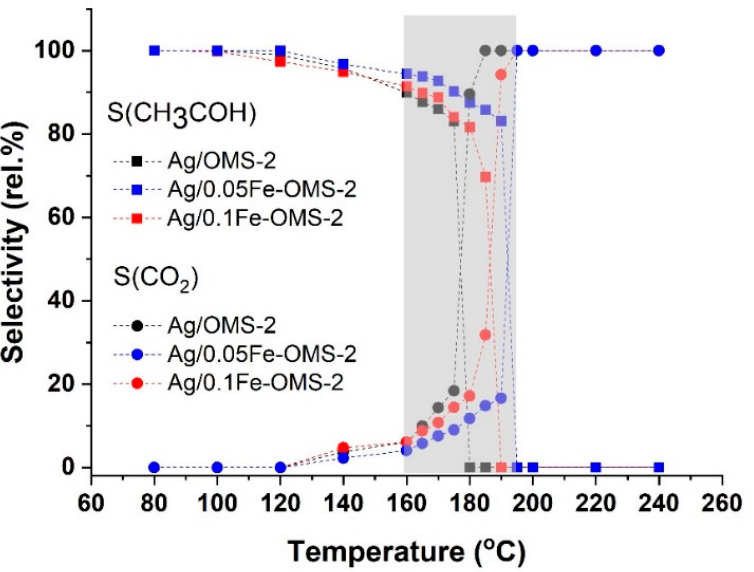
Figure 4. Temperature dependences of acetaldehyde and CO 2 selectiveness for prepared samples. Reaction conditions: GHSV = 7200 mL g − 1 h − 1 , Et/O 2 =